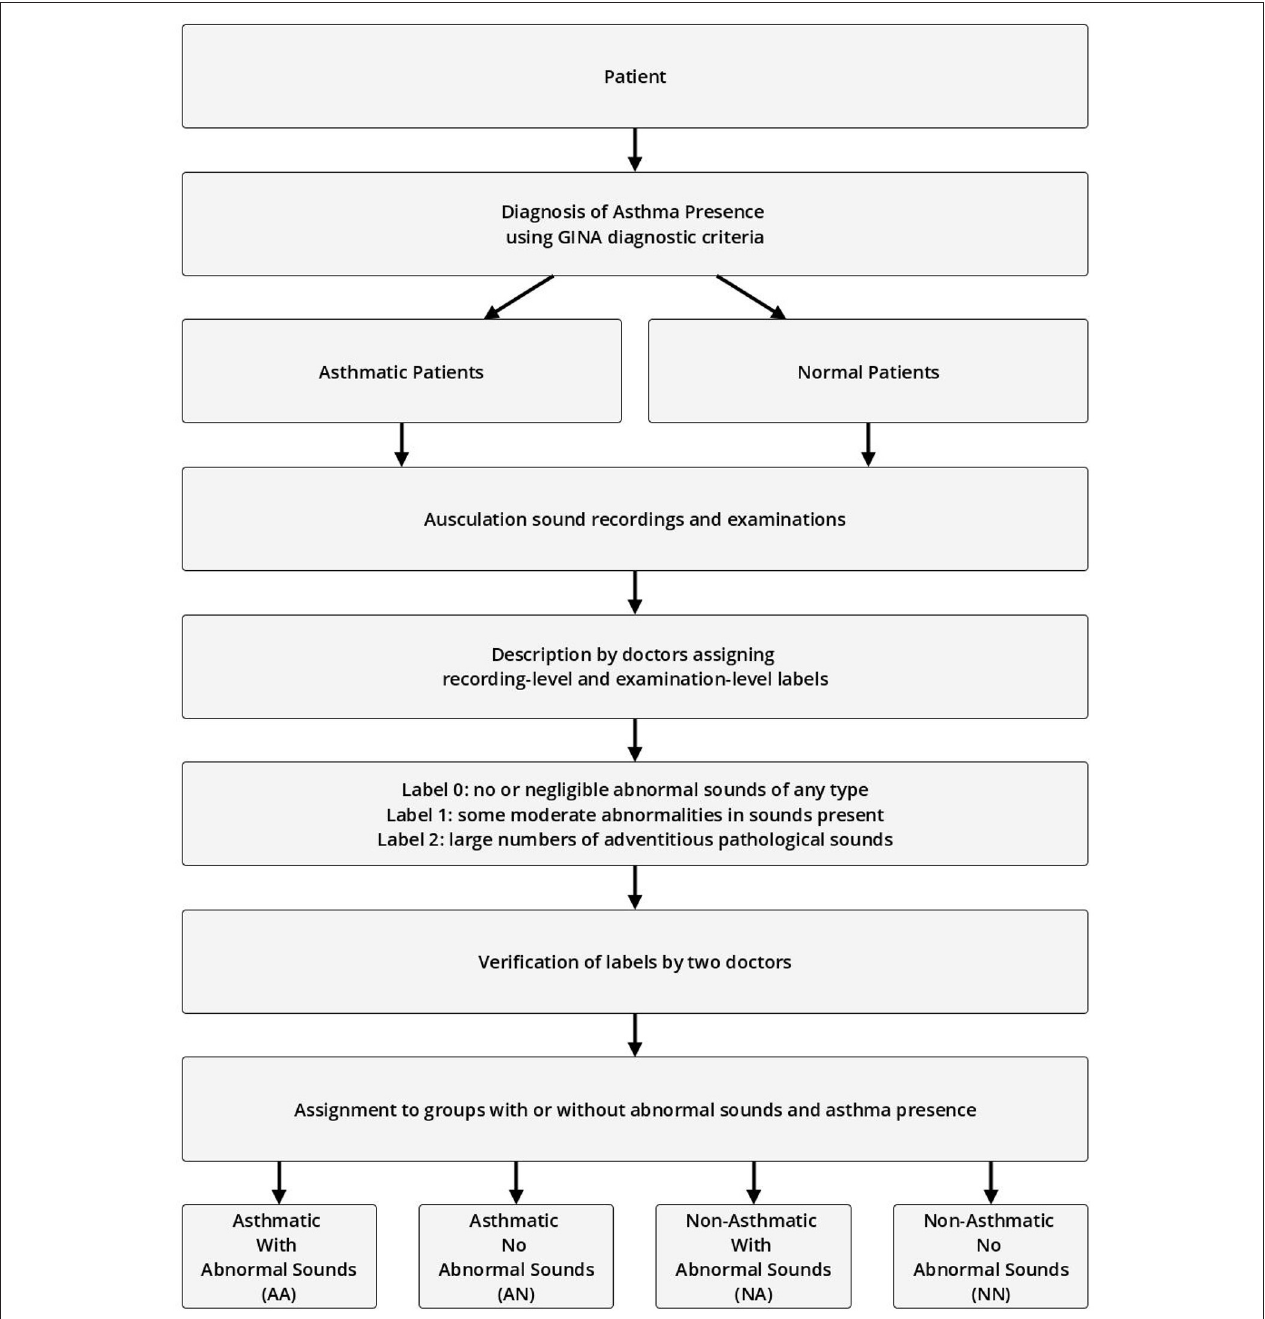
FIGURE 1 | Process of assigning patients, examinations, and recordings to groups based on presence of abnormal sounds and asthma diagnosis.